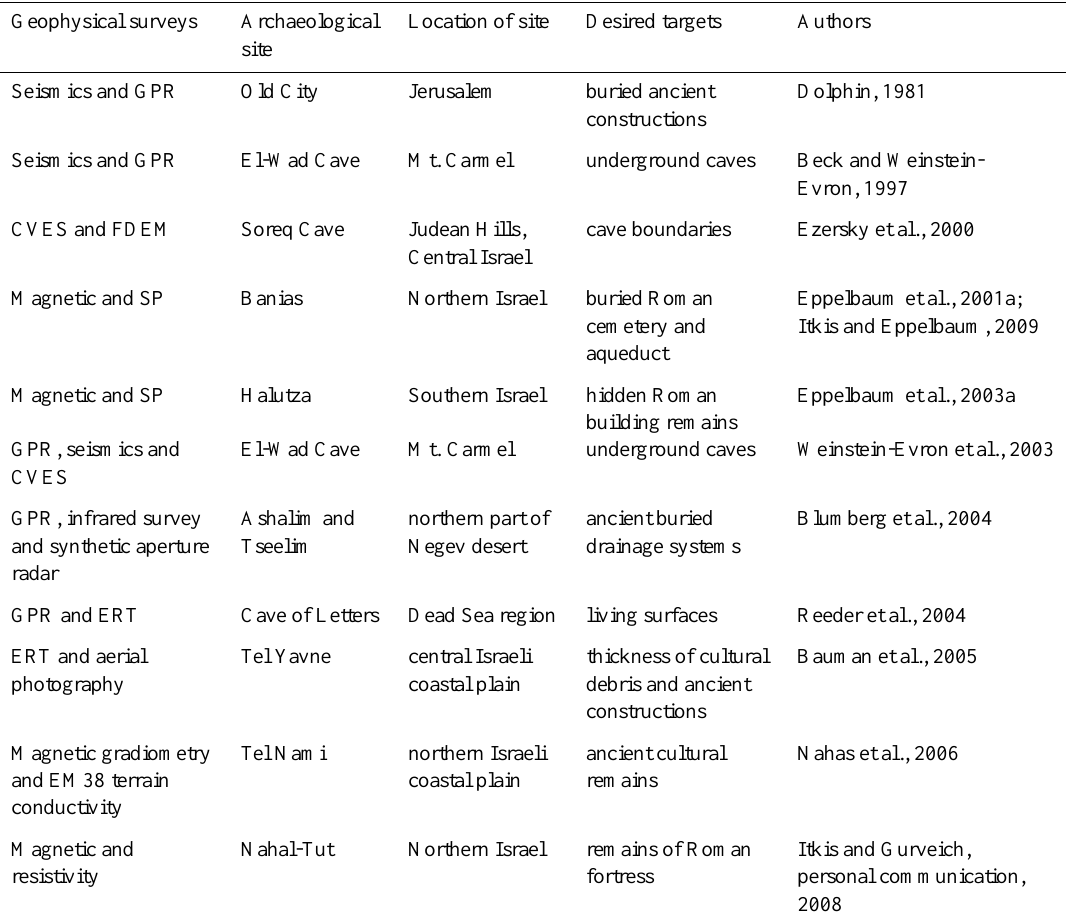
Table 2. Integrated geophysical investigations at archaeological sites in